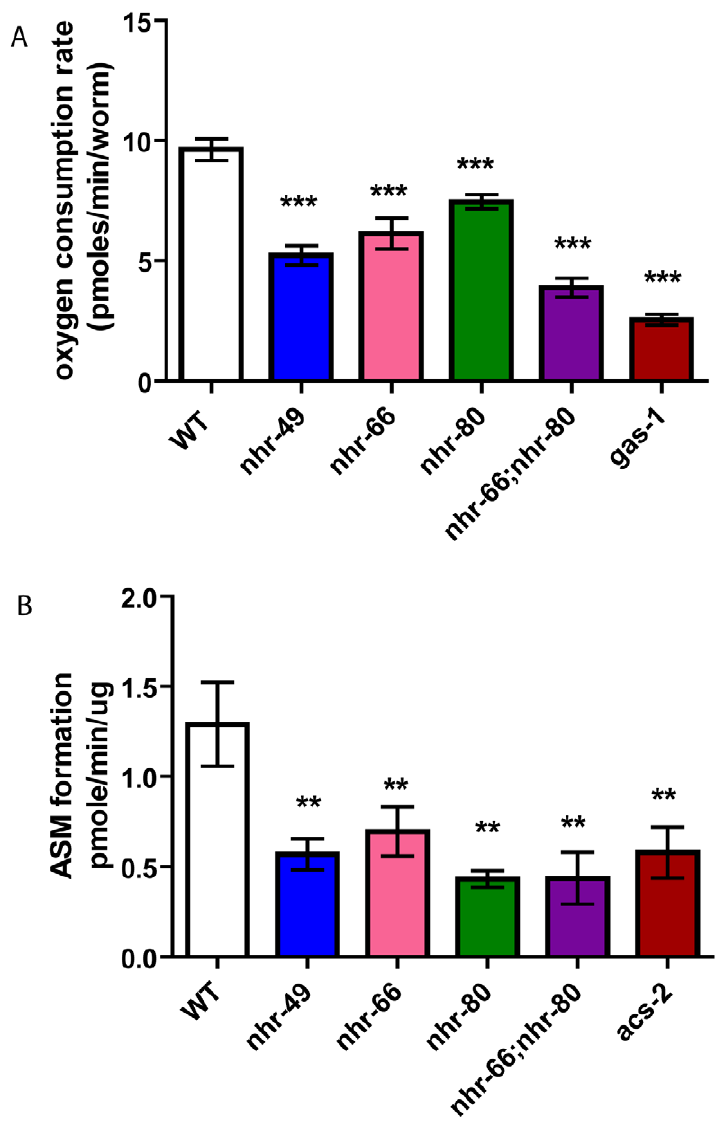
Figure 8. nhr-49 animals have reduced basal oxygen consumption rates and reduced beta-oxidation. (A) Basal oxygen consumption rates of WT, nhr-49 , nhr-80 , nhr-66 , nhr-66; nhr-80 and gas-1 animals. P-values were obtained using the unpaired t-test. *** p , 0.001. (B) Evaluating b - oxidation by measuring amounts of radiolabeled acid-soluble metabolites in WT, nhr-49 , nhr-80 , nhr-66 , nhr-66; nhr-80 and acs-2 animals. The data represents the average results from two independent experiments. The results are expressed as means + / 2 SEM (n=6) normalized to the specific activity of the radioactive palmitate. One-way ANOVA was used to compare with the Neuman-Keuls multiple comparison tests. ** , p , 0.01, *** p ,